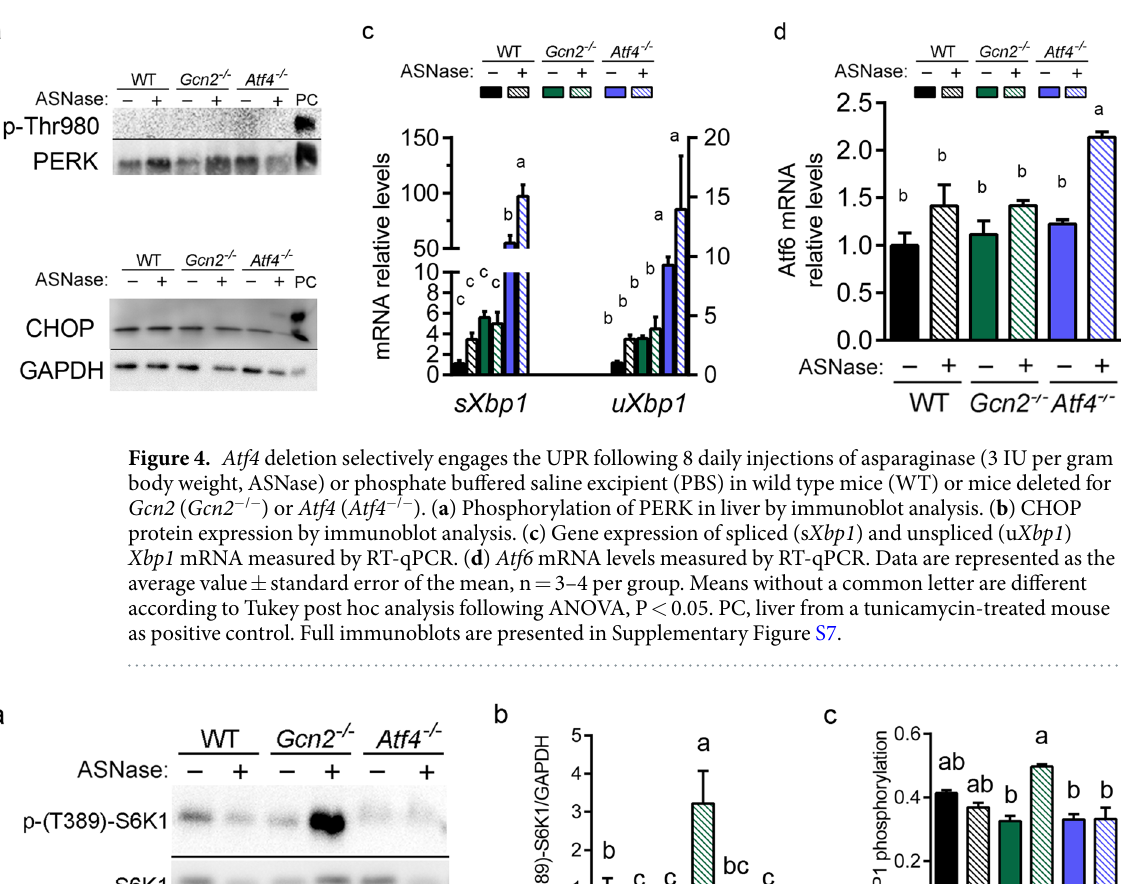
Heterozygous loss of Atf4 promotes hepatic ER stress and apoptosis to asparaginase. Atf4 − / − mice exhibit pleiotropic phenotypes of reduced growth, lack of vision, and defects in hematopoiesis and glu- cose homeostasis 27, 34–36 . These health challenges may serve as confounders in the assessment of Atf4 deletion during asparaginase exposure. To help assess this, we decided to examine the impact of asparaginase exposure in Atf4 heterozygotes ( Atf4 + / − ) which appear normal and healthy. To understand if ATF4 haploinsufficiency altered the hepatic ISR and health status to asparaginase, we examined the effects of asparaginase on Atf4 + / − mice compared to WT and Atf4 − / − . Prior to treatment, Atf4 − / − but not Atf4 + / − mice were leaner than Atf4 + / + mice